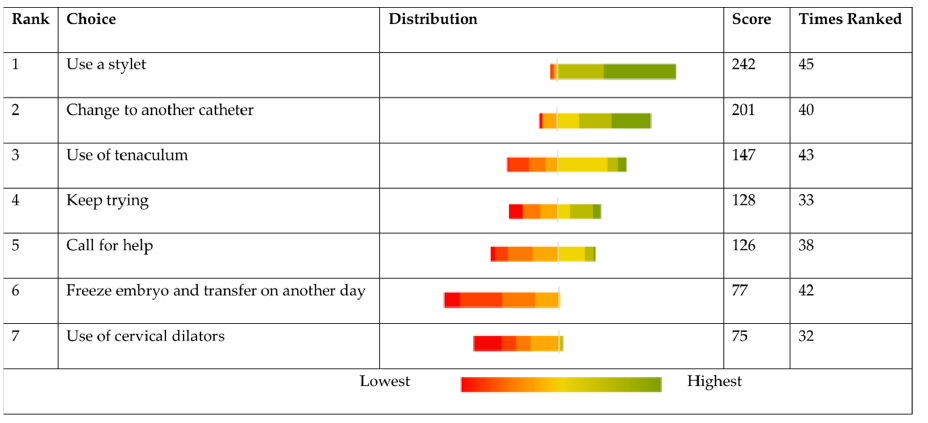
Figure 2. If there is difficulty in ET, what would be your preferred options in order